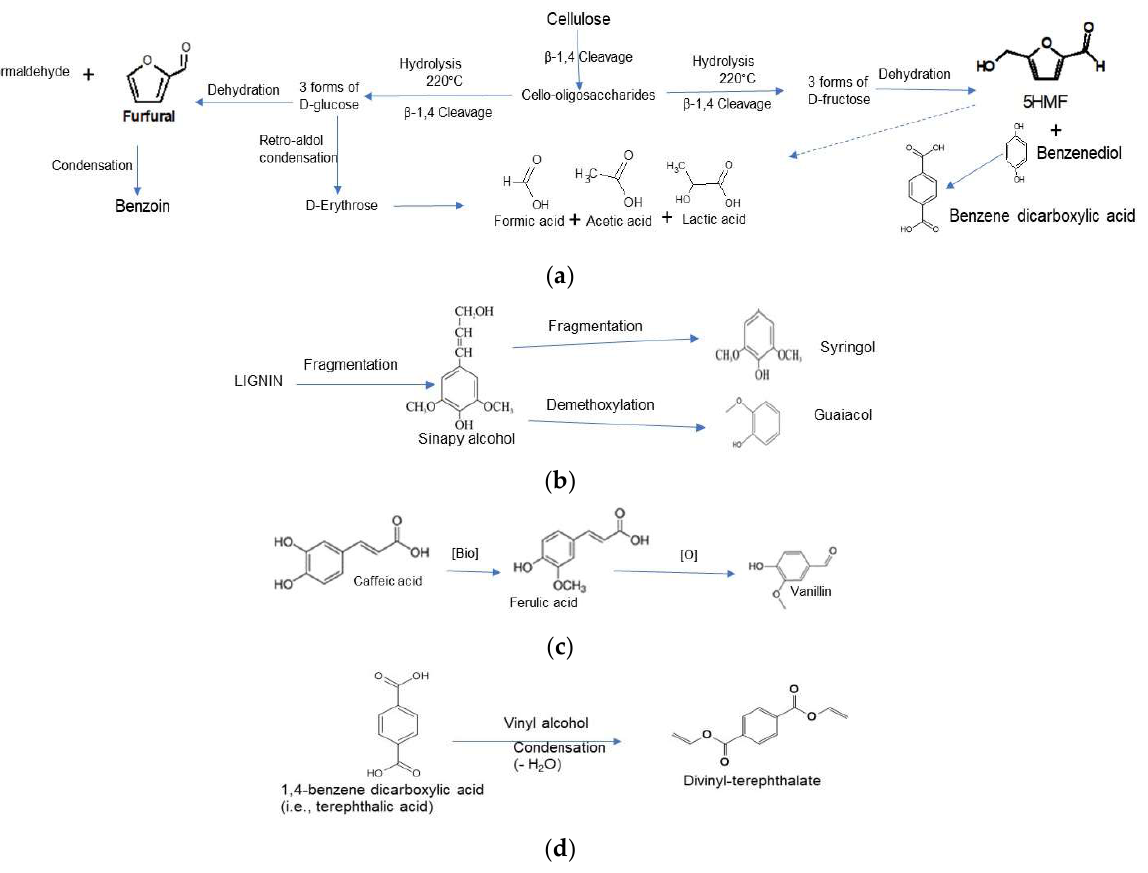
Figure 3. ( a ). Cellulose degradation steps producing furfural, 5HMF and other products during HTC process. ( b ). Lignin transformation into syringol and guaicol. ( c ) Transformation of caffeic acid into vanillin via ferulic acid. ( d ). Condensation of Phthalic acid with vinyl alcohol into divinyl-tetephthalate.